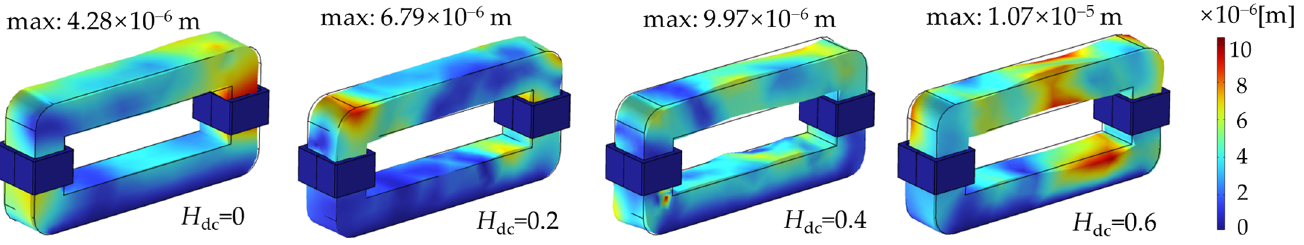
Figure 12. Overall deformation distribution of HFT with interleaved winding.